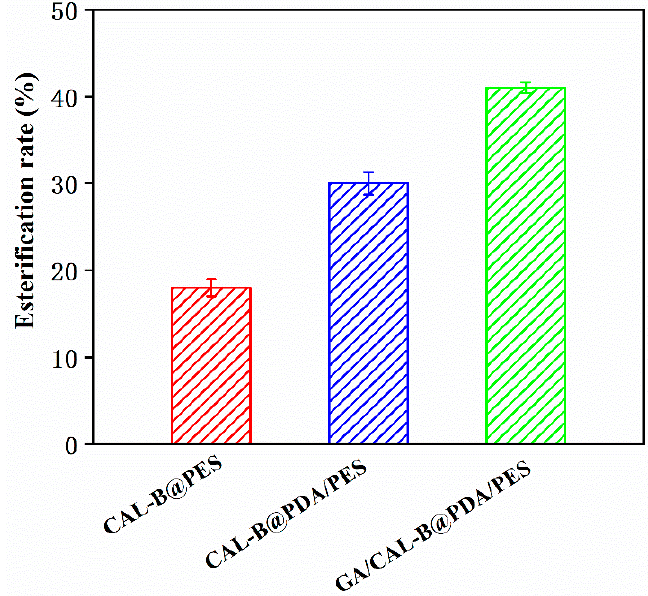
Figure 10. Esterification rate of hesperidin for different BLIMs.